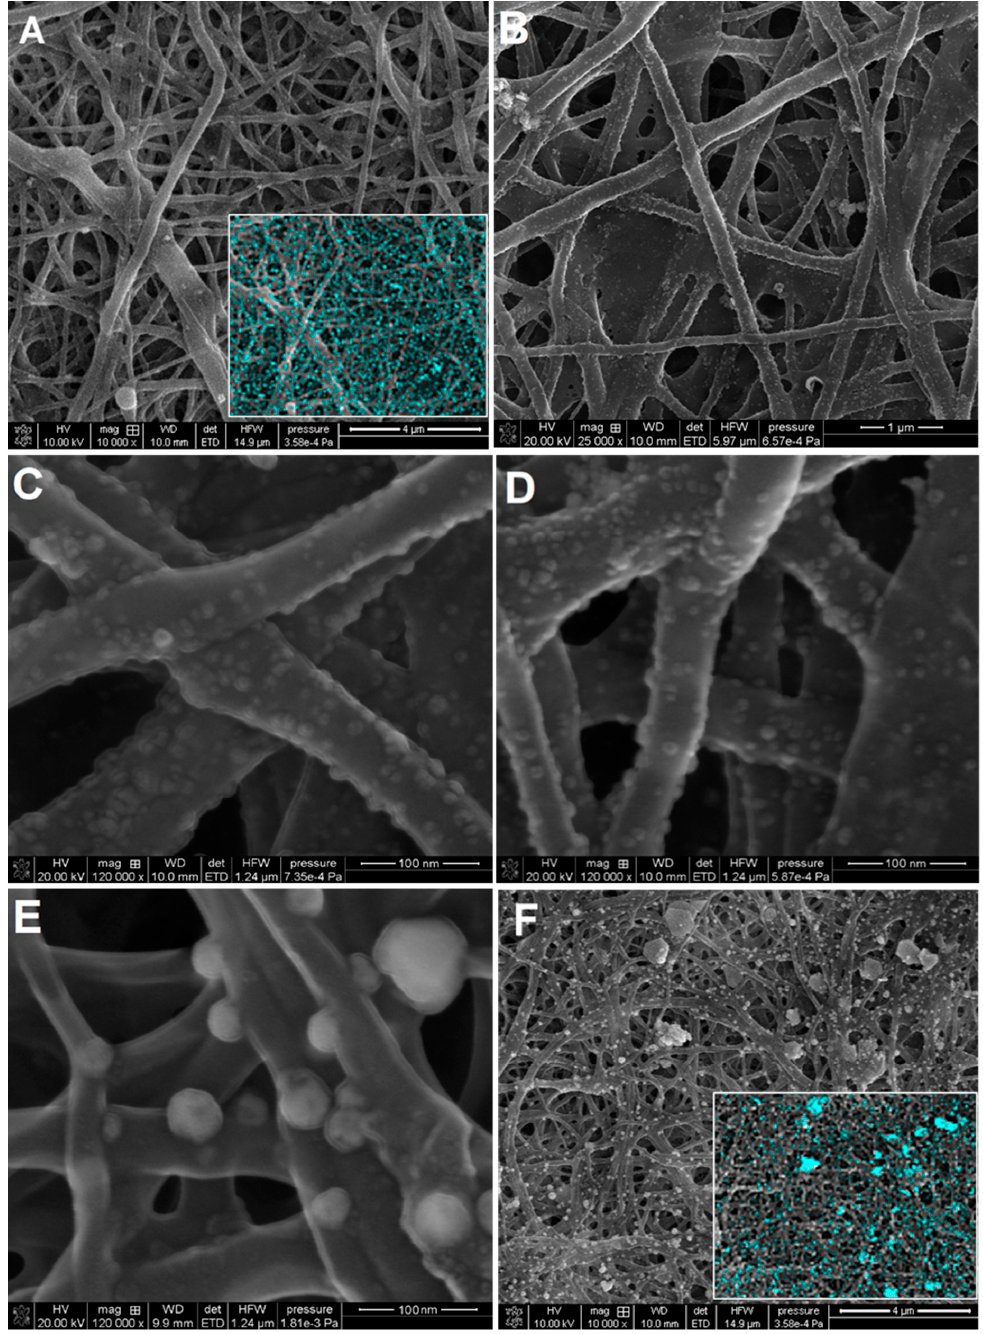
Figure 11. SEM images of the investigated nanocomposites, ( A ) BP, ( B – D ) BP / AgP, and ( E , F ) BP / AgNP. Insets presented in Figure 11A,F present the combination of SEM imaging with energy-dispersive X-ray spectroscopy (EDX). Blue objects represent the map of AgL signals.